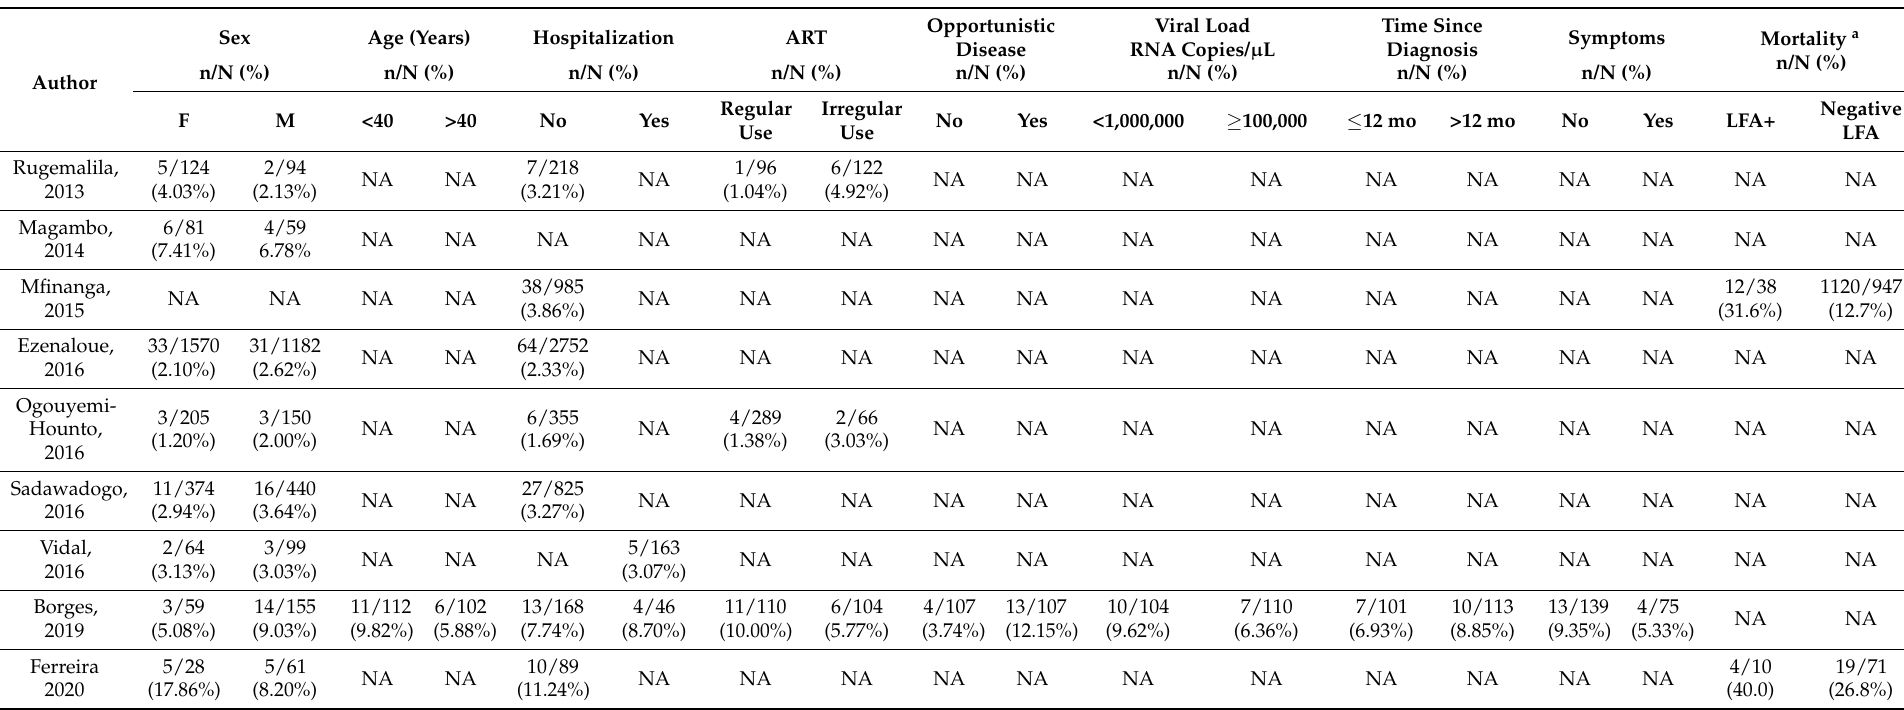
Table 1. Studies included in the prior distribution for each group with the number of positive LFA cases and sample sizes for each